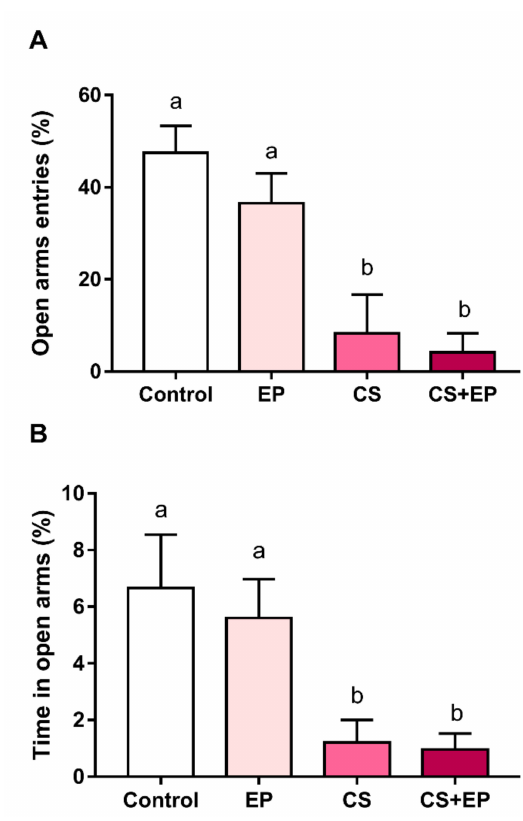
Figure 1. E ff ects of experimentally induced chronic immobilization stress and ligature-induced periodontitis on anxiety-like behavior of male Wistar rats (90-days-old, n = 28). ( A ) Entrance frequency in open arms (%) and ( B ) time in the open arms (%) in the elevate plus maze; results are expressed as mean ± standard error. One-way ANOVA and Tukey’s post-hoc test, p < 0.05. Similar overwritten letters did not show statistically significant di ff erences. EP: ligature-induced experimental periodontitis group; CS: chronic stress by physical restraint model; CS + EP: association of chronic stress and ligature-induced